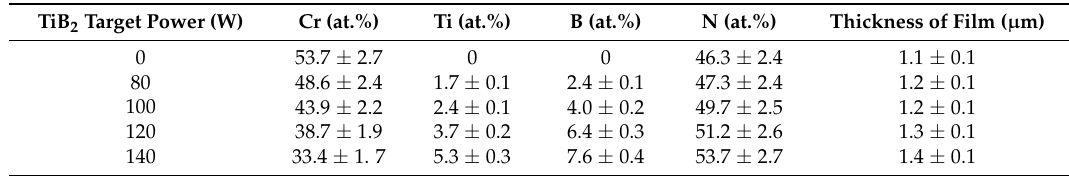
Table 1. Elemental compositions and film thickness of Cr ‐ Ti ‐ B ‐ N films with various the powers of TiB 2 composite target.